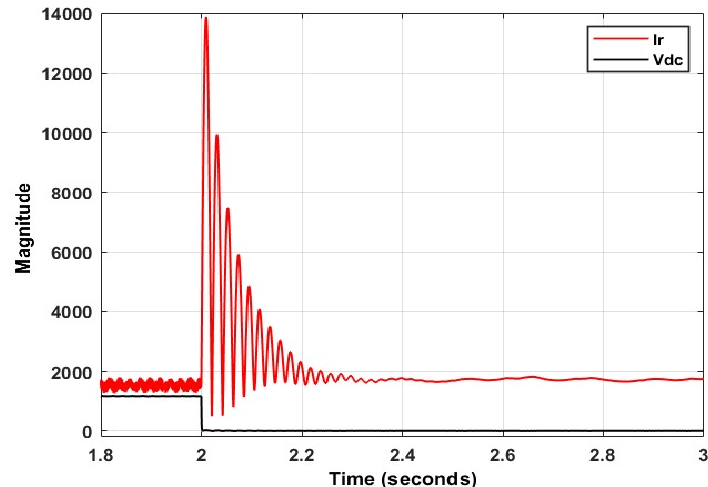
Figure 1. General structure of DFIG [2].